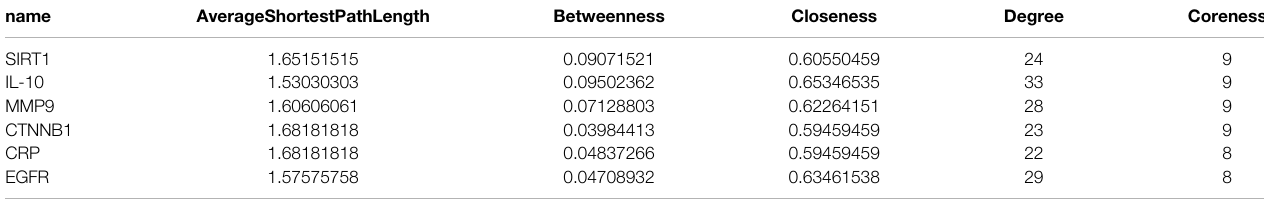
TABLE 3 | Core targets and correlation coef fi cients.